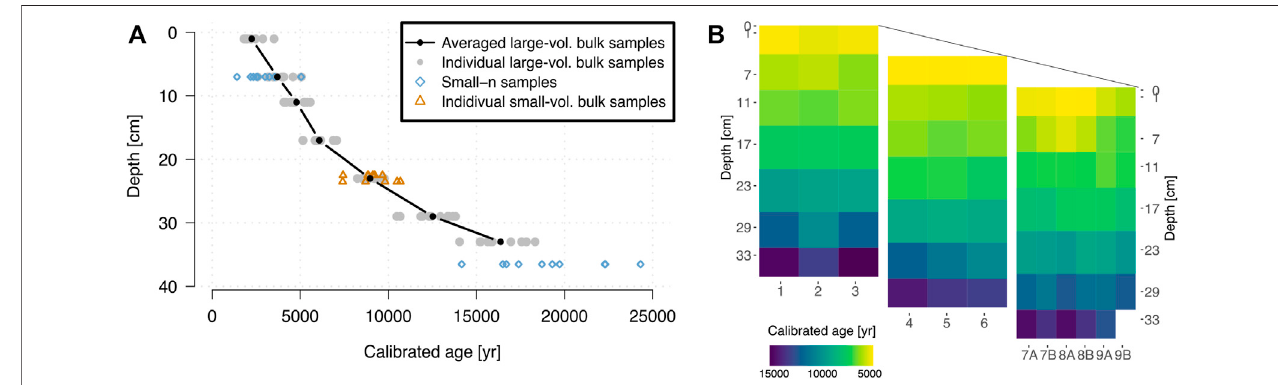
FIGURE 3 | Depth-age illustrations for calibrated radiocarbon ages. (A) Calibrated ages for the large-volume bulk samples are shown with gray points and their respectivemeanperdepthlayerillustratedinblack.Measurementerrorsforsingledatapointsarenotdisplayedduetotheirsmallmagnitude.Thebluediamondsareage estimates based on small-n samples while the golden triangles show ages from the small-volume bulk samples. (B) Absolute calibrated calendar ages from the large- volume bulk samples are illustrated for each sub-core and arranged according to the sub-sampling of the core to illustrate the three dimensions (see Figure 2B ).